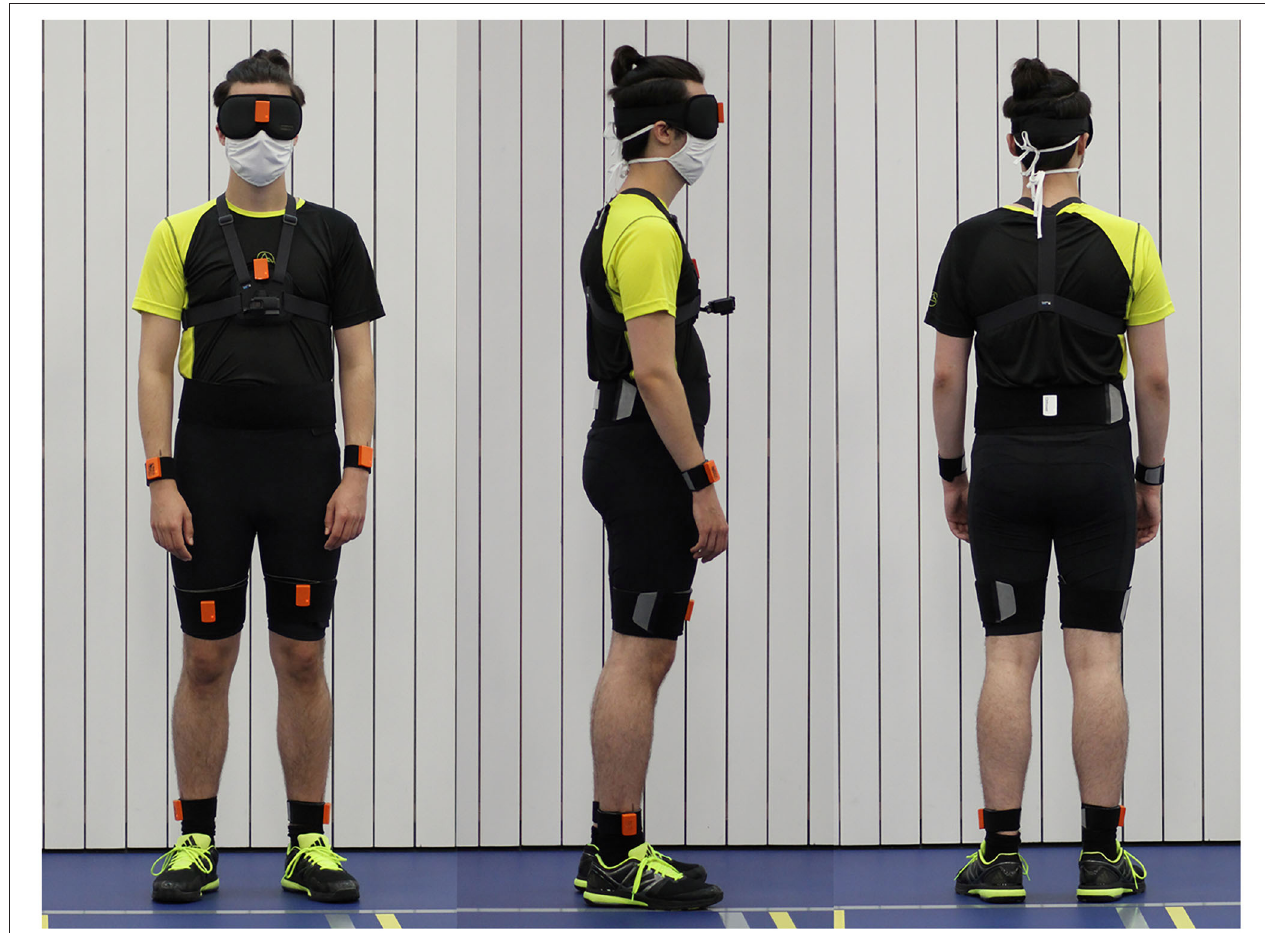
FIGURE 1 | The fully-equipped participant during the study; 9 IMUs (MTw Awinda, Xsens Technologies B.V., Enschede, Netherlands) were attached to the subject with Velcro ® patches and bands at both ankles, both thighs, lower back, chest, both wrists, and at the forehead. Sensory shoe insoles (Insole3, Moticon ReGo AG, Munich, Germany) were laid in the subject’s own shoes. Additionally, the subject wore a GoPro Hero 6 on a chest mount (GoPro Inc., San Mateo CA, USA), a sleeping mask and